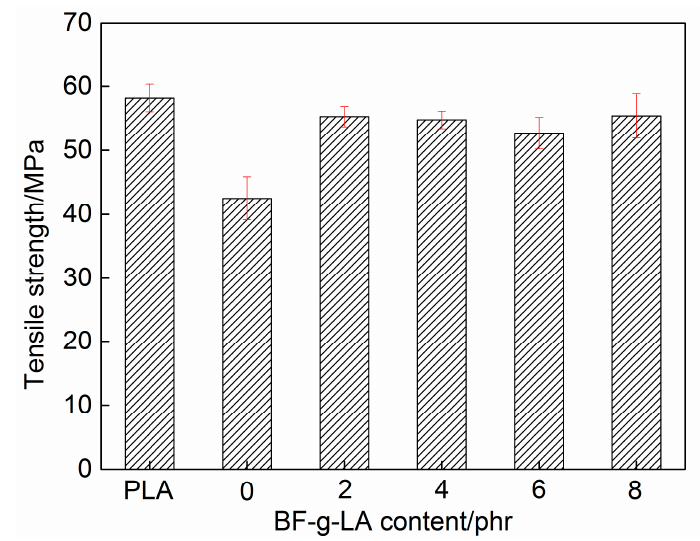
Figure 5. Tensile strength of PLA/BF/BF- g -LA composites.